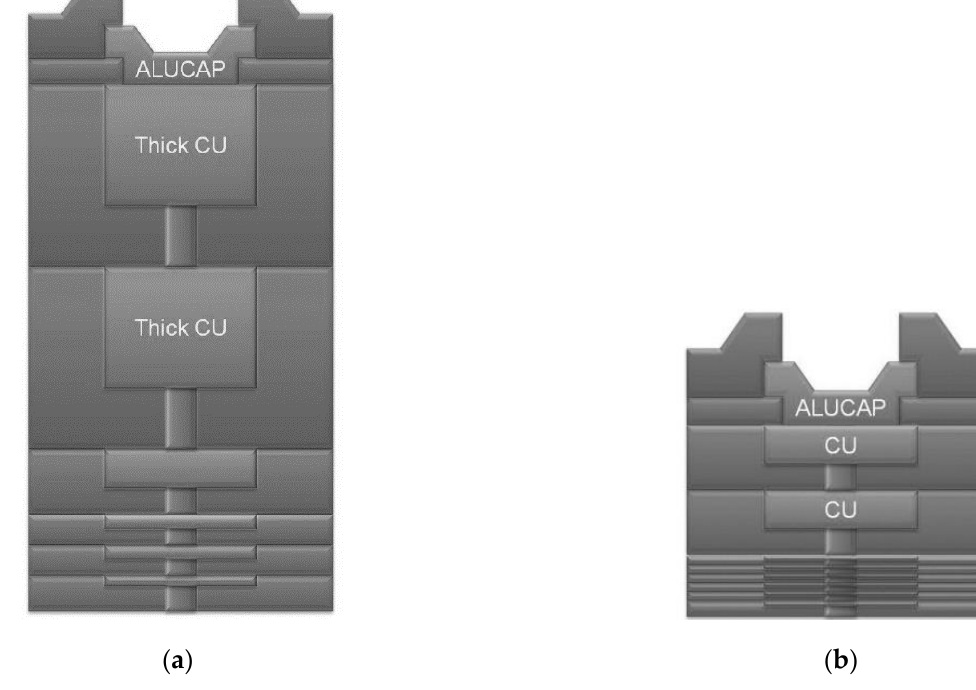
Figure1. Back-end-of-line(BEOL)comparisonbetween( a )mm-wave-optimizedBiCMOStechnology[4] Figure 1. Back-end-of-line (BEOL) comparison between ( a ) mm-wave-optimized BiCMOS technology and ( b ) 28 nm CMOS technology with standard BEOL [4] and ( b ) 28 nm CMOS technology with standard BEOL [9].